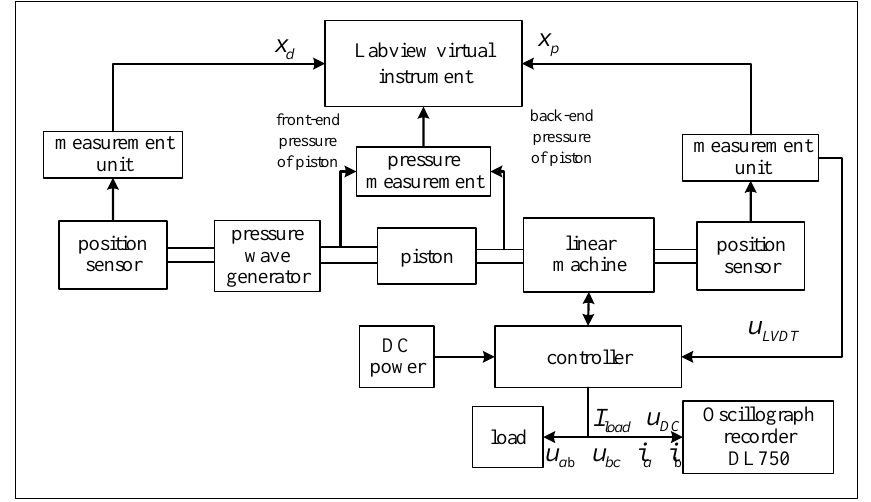
Figure 11. Test platform of the power generating system.